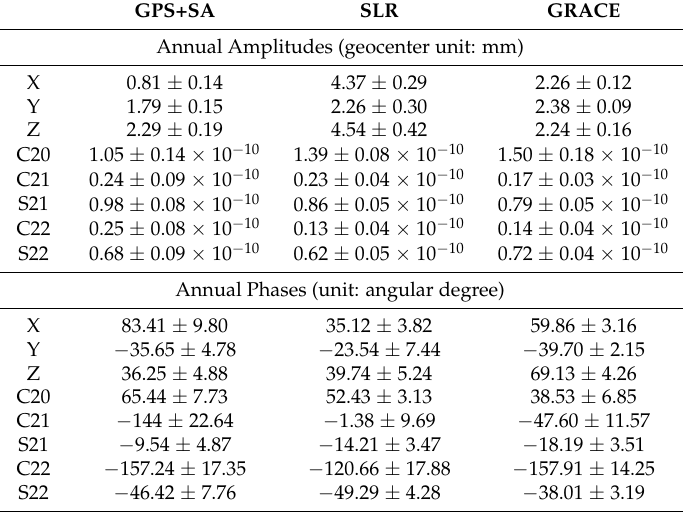
Table 1. Annual variations of the geocenter and degree-2 gravity coefficients estimated from GPS+SA, SLR and GRACE. GPS+SA means results combining GPS and SA with the truncation degree at 60. SLR results are from [9,10]. GRACE geocenter is computed by combination of GRACE and OBP [38]. GPS+SA SLR